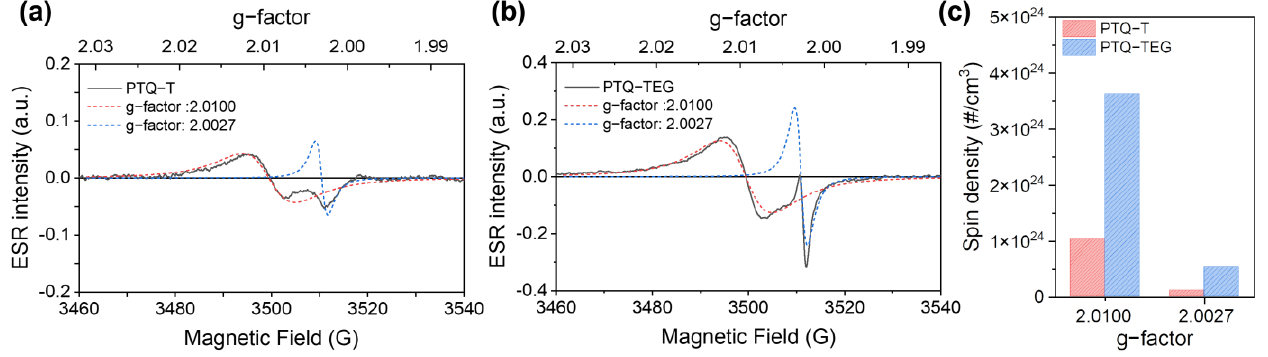
Figure 5. ESR signals and corresponding g-factors of ( a ) PTQ-T and ( b ) PTQ-TEG and comparison of the spin density of each ESR component. ( c ) indicates the spin density corresponding to each g-factor in ESR signals of both CPs.